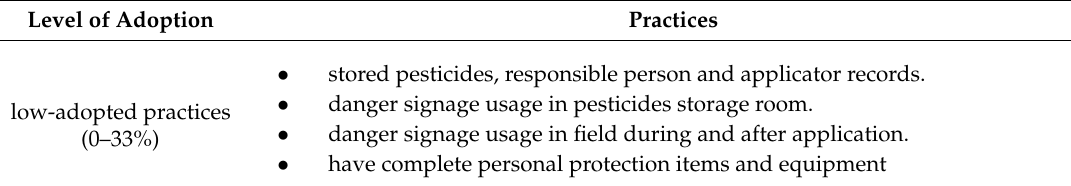
Table 3. GPAR: Level of adoption of good practices in pesticide use for vegetable and berry producers. Level of